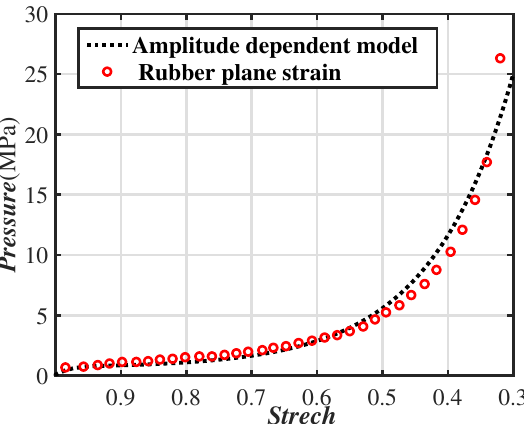
Figure A2. Simulated behavior and ramp test results of silicone rubber plane compression